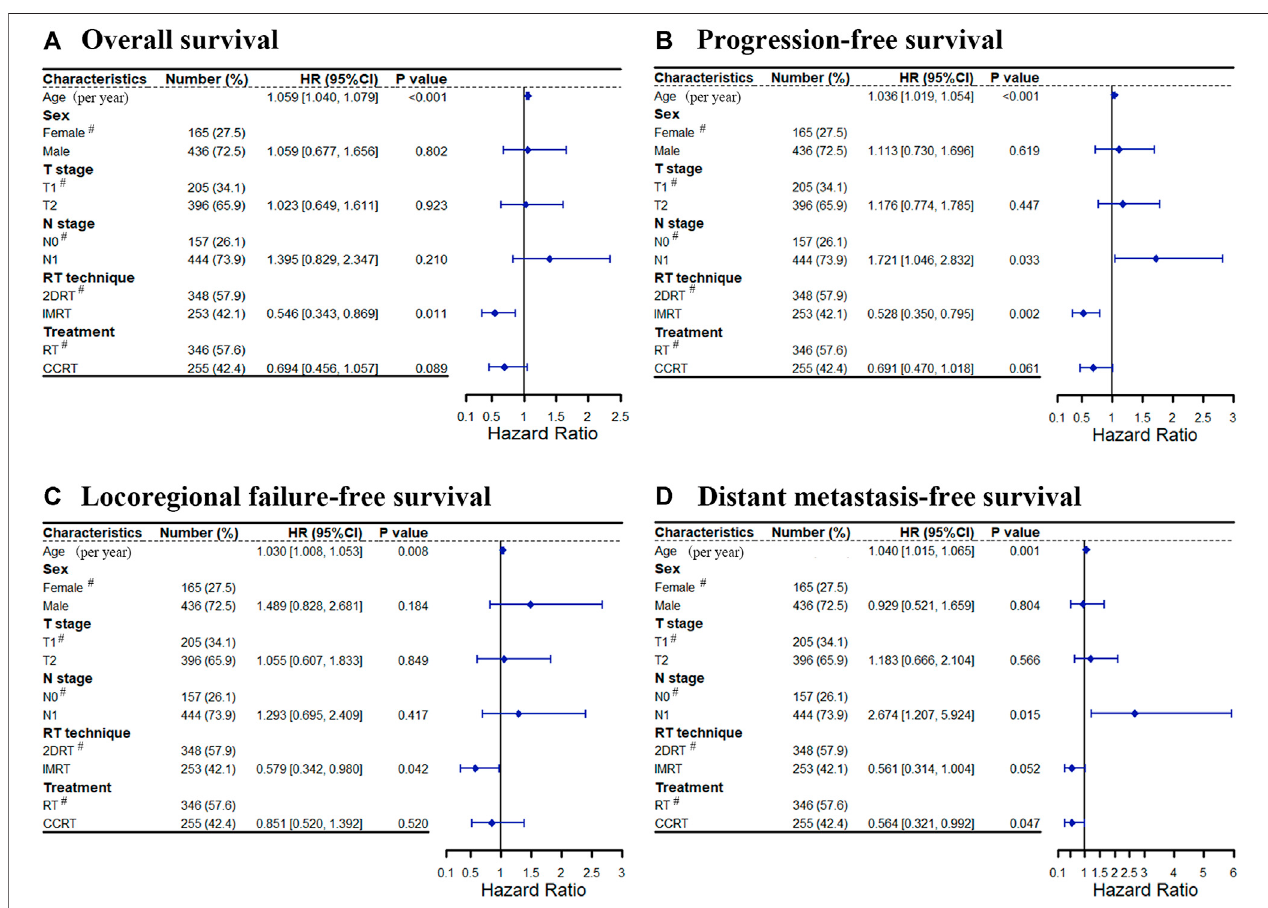
FIGURE 5 | Cox forest for treatment outcomes: (A) Overall survival, (B) Progression-free survival, (C) Locoregional failure-free survival, (D) Distant metastasis-free survival.Abbreviation:RT (cid:1) radiotherapy,CCRT (cid:1) concurrentchemoradiotherapy,2DRT (cid:1) two-dimensionalradiotherapy,IMRT (cid:1) intensity-modulatedradiotherapy,HR (cid:1) hazard ratio, # (cid:1)